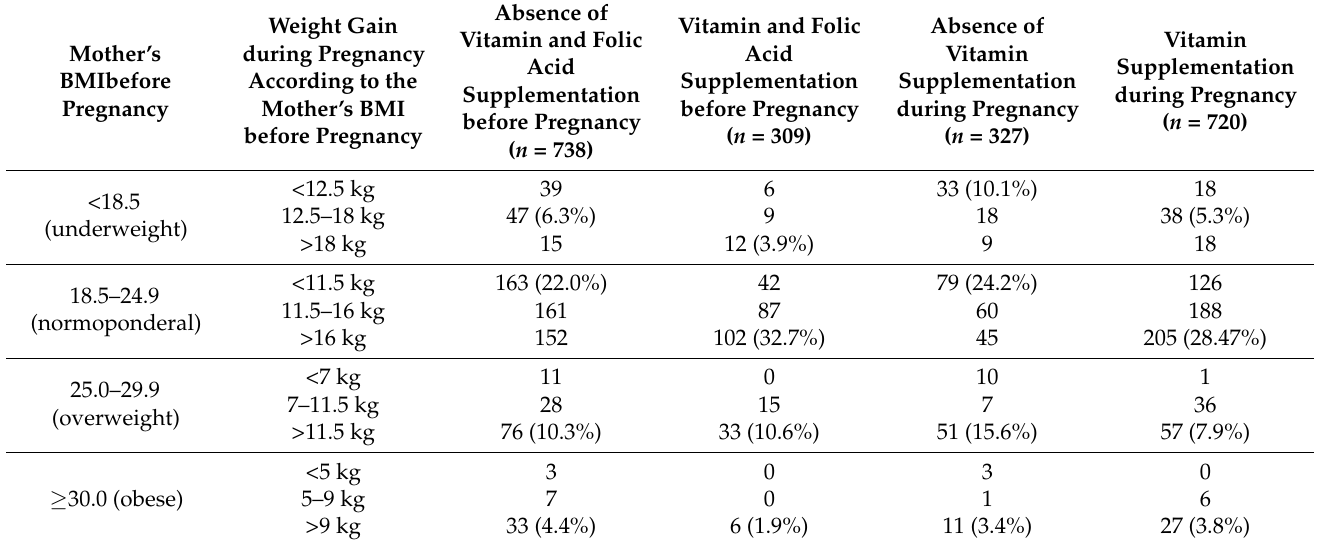
Table 7. Weight gain of the mother based on vitamin supplements intake, before and during